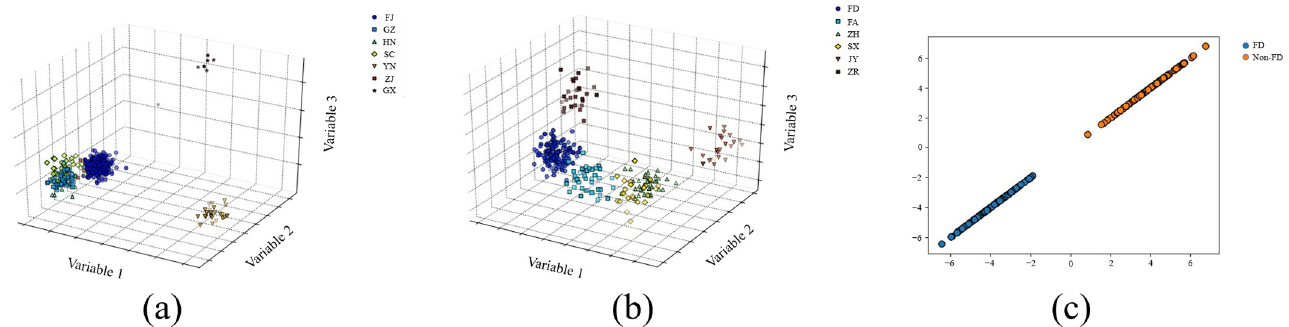
Figure 7. Visualization of the best models for white tea origin traceability. ( a ) DPC-CWT-LDA-KNN; ( b ) DDFP-OS-LDA-KNN; ( c ) AFWT-OS-LDA-KNN.